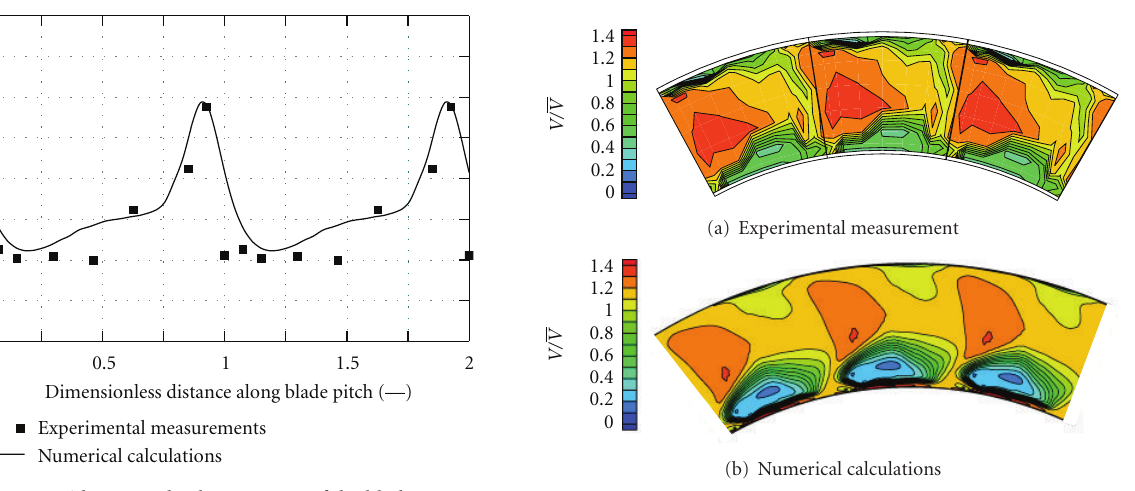
Figure 9: Downstream dimensionless